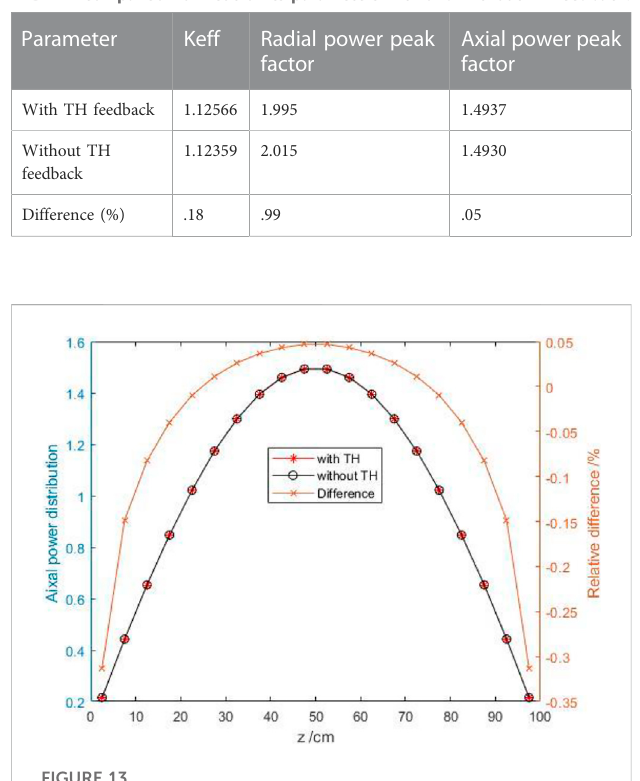
TABLE 2 Comparison of neutronics parameters with and without TH feedback.